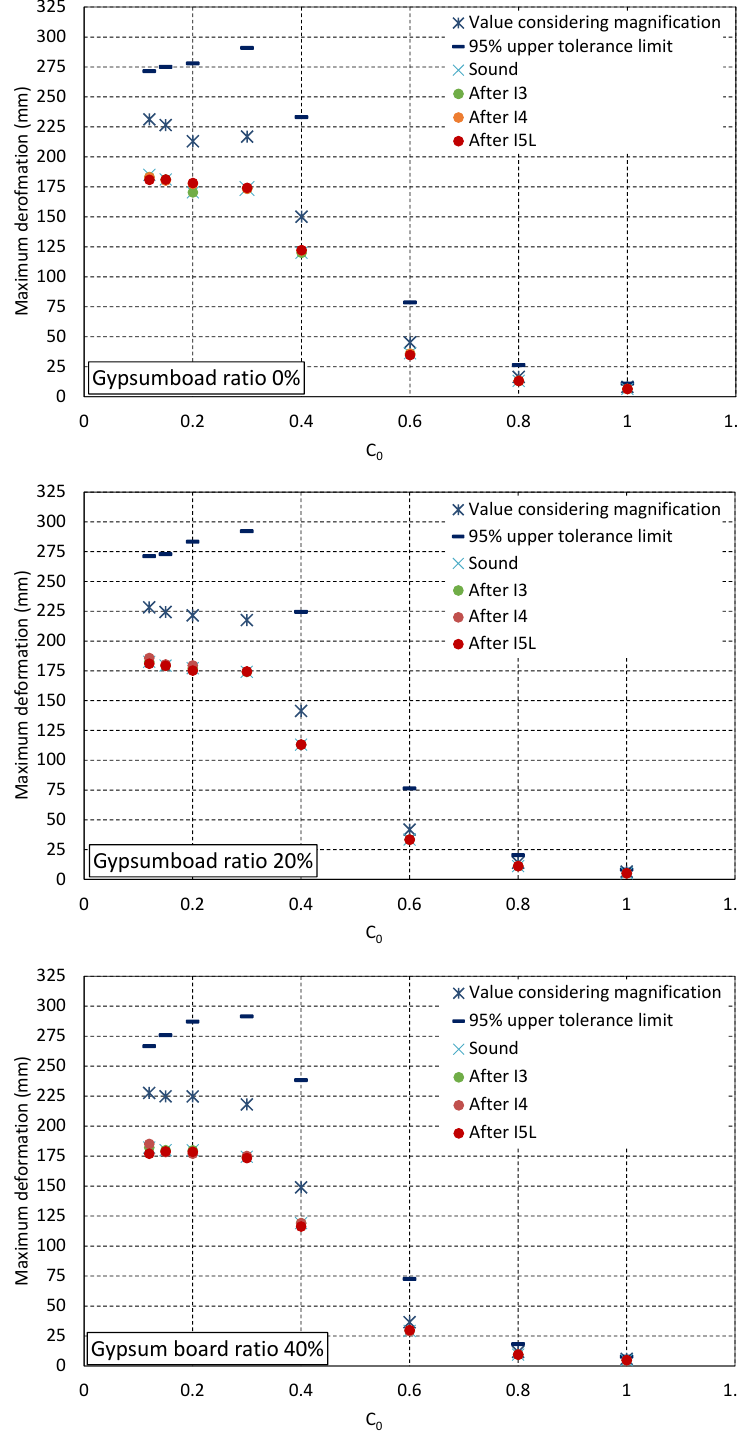
Figure 14. Response deformation considering magnification. No clear differences in maximum response deformation or response factor were found Table 7. Magnifications of maximum deformation. between the different ratios of gypsum board in terms of shear capacity. This is thought to be because the response deformation will always enter a new area in the case of a large-scale earthquake. From this, it could be argued that gypsum boards do not need to be taken into consideration when discussing the impact of medium earthquakes in terms of response at the time of large-scale